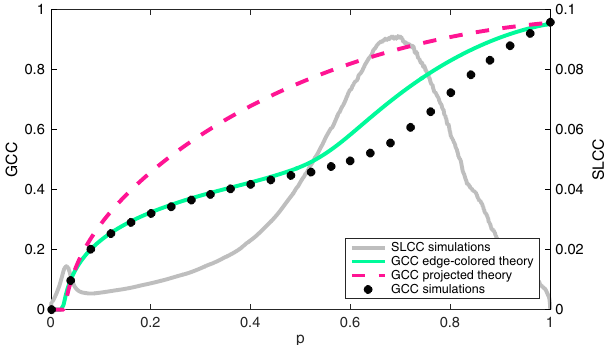
FIG. 4. Expected size of the GCC as a function of p for a two- layer multiplex network constructed from the London rail trans- portation network and the EU air transportation network. Numerical simulations are averaged over 1000 realizations. Peaks in the expected size of the SLCC indicate percolation